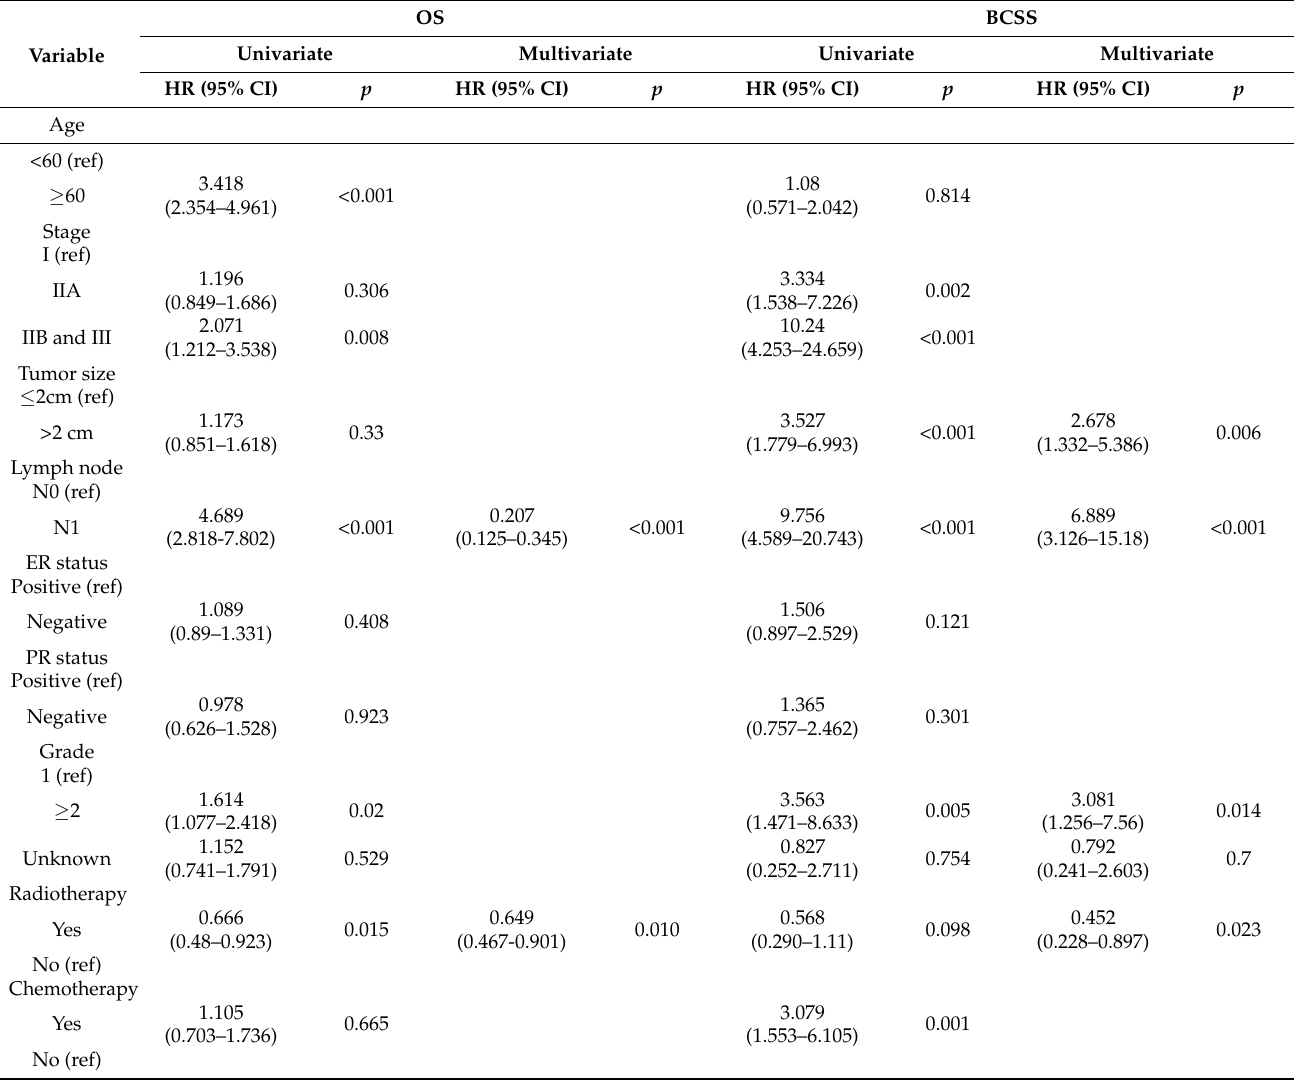
Table 2. Univariate and multivariate analyses of factors influencing OS and BCSS in